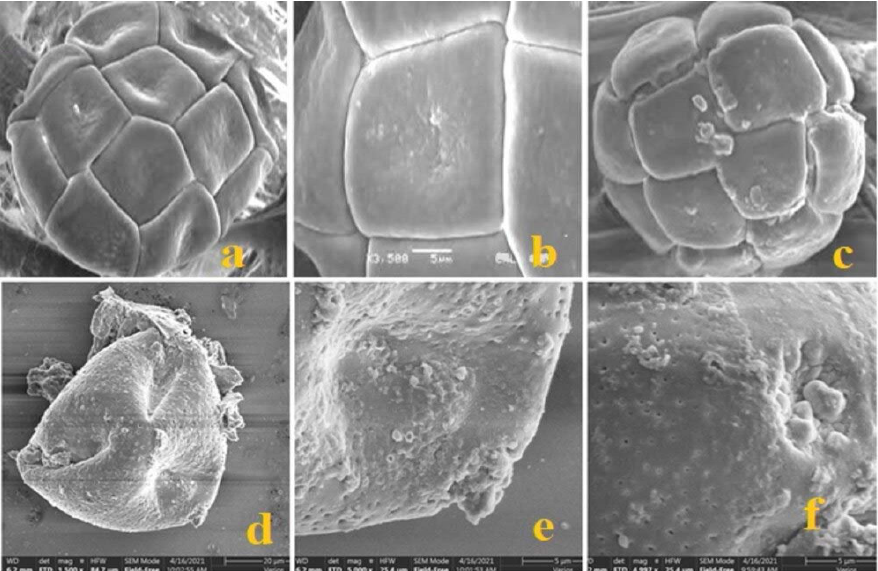
Figure 2. SEM micrographs showing the pollen grains of Mimosa pudica Wanning, showing ( a ) close view of exine sculpturing, ( b ) the polar area and ( c ) equatorial view. Mimosa diplotricha Beihualing ( d – g ), showing ( d ) equatorial view, ( e ) polar view, ( f ) close view of the exine and ( g ) prolate-shaped pollen. Mimosa diplotricha Haikou ( h , i ), showing ( h ) polar view and ( i ) close view of the exine sculpturing. Scale bars: a = 1 µm; b,c = 4 µm; c = 10 µm; d,e = 10 µm; f = 3 µm; g,h = 10 µm; i = 3 µm.